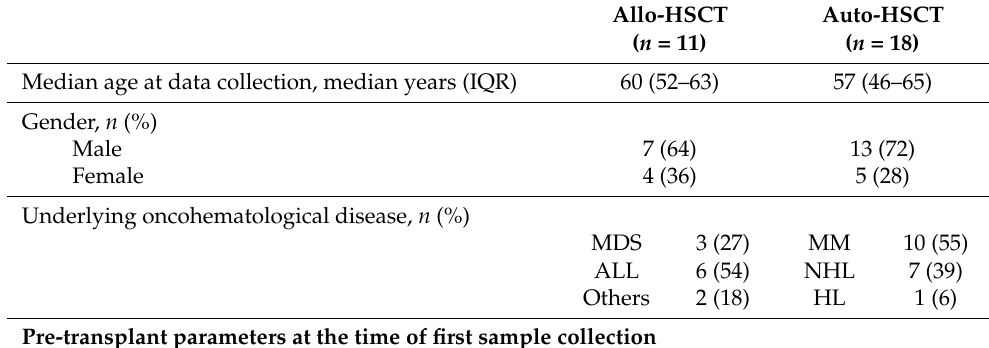
Table 1. Sociodemographic and clinical data of the individuals with allogeneic or autologous trans- plantation who participated in this